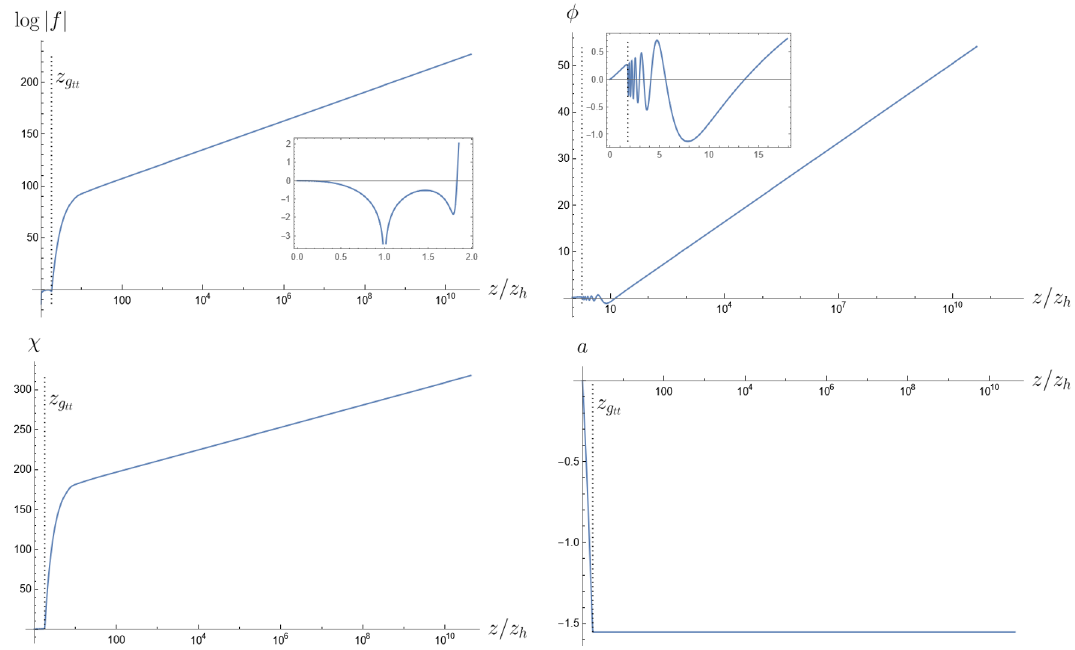
Figure 7 . Sample solution for the charged case, without Kasner inversion. For illustration